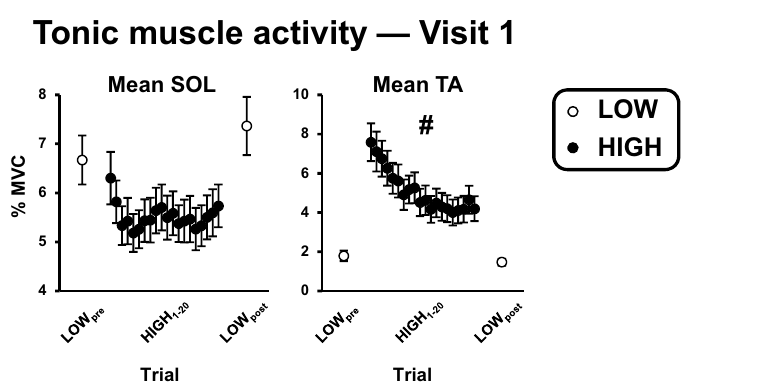
Figure 3. Effect of threat and trial on standing balance outcomes. Data presented reflect group means and standard errors. The first two and last two LOW trials have been averaged (LOW pre and LOW post , respectively) and are represented as open circles, while data across HIGH trials 1–20 are represented as filled black circles. COP = centre of pressure; HF = high frequency (1.8–5 Hz); LF = low frequency (0–0.05 Hz); MF = medium frequency (0.5–1.8 Hz); MPF = mean power frequency; MPOS = mean position; RMS = root mean square; SOL-TA = soleus-tibialis anterior. Hashtags indicate significant threat × trial interactions resulting from a reduced effect of threat as a function of repeated exposure.